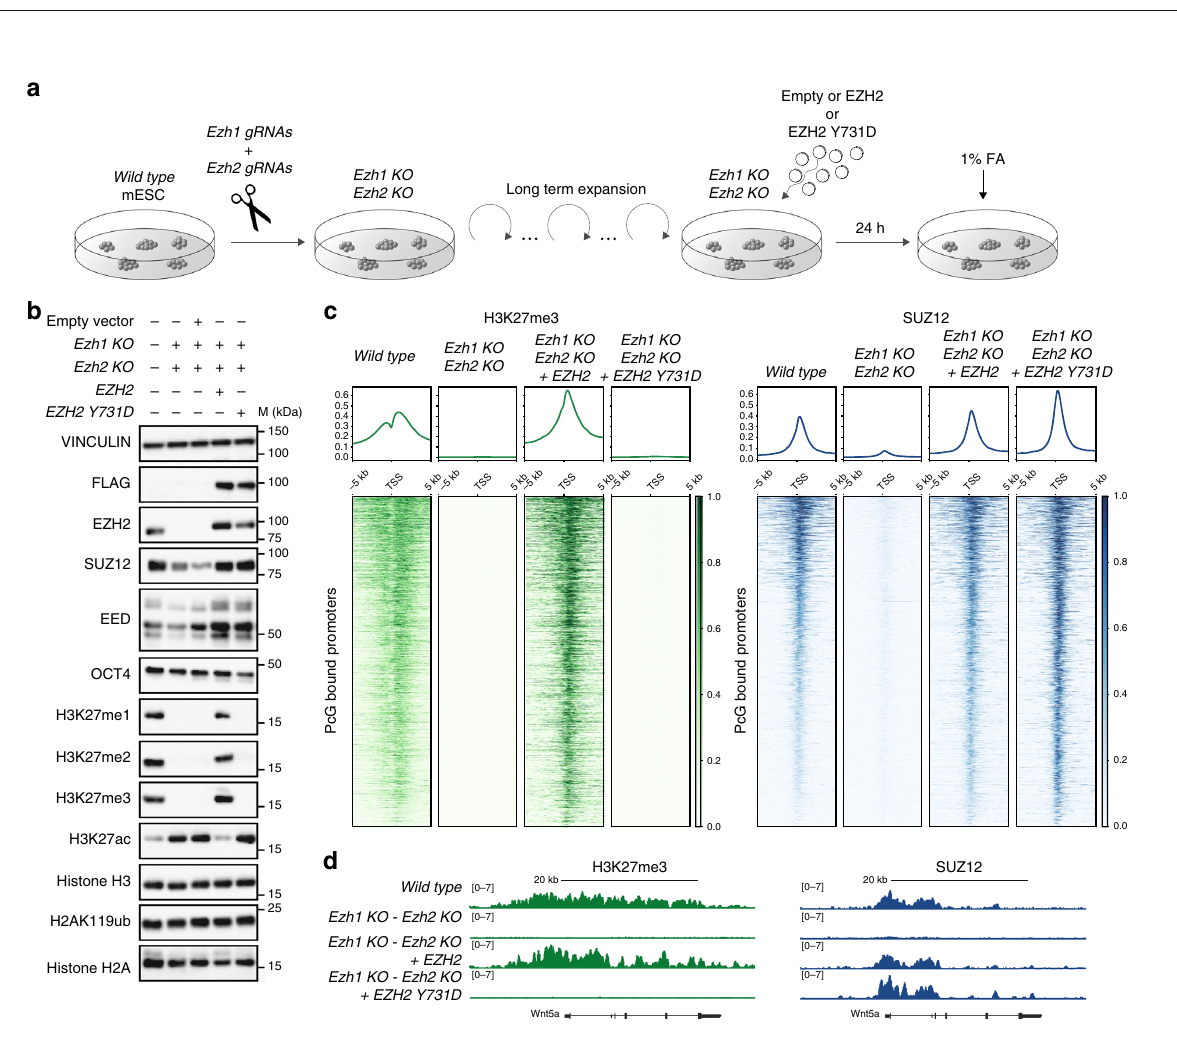
Fig. 3 De novo PRC2 recruitment is independent of H3K27 methylation. a The experimental strategy used for de novo recruitment experiments. b Western blot analyses with the indicated antibodies using protein extracts obtained from WT, Ezh1/2 dKO, and Ezh1/2 dKOs cells transiently transfected with vectors expressing human EZH2 or EZH2Y731D (Y726D in mouse). Empty vector was used as negative control of transfection. Vinculin, histone H3, and histone H2A served as loading controls. c Heatmaps representing the spike-in normalized H3K27me3 ChIP-seq intensities and the normalized SUZ12 ChIP- seq signals ± 5 kb from TSS of SUZ12-bound promoters in the cell lines presented in a . Promoters were ranked according to SUZ12 intensities in WT mESCs. Upper panels, enrichment plots representing the average distribution of H3K27me3 and SUZ12 ± 5 kb around TSS. d Genomic snapshots for H3K27me3 and SUZ12 ChIP-seq analyses performed in the indicated cell lines at the Wnt5a locus